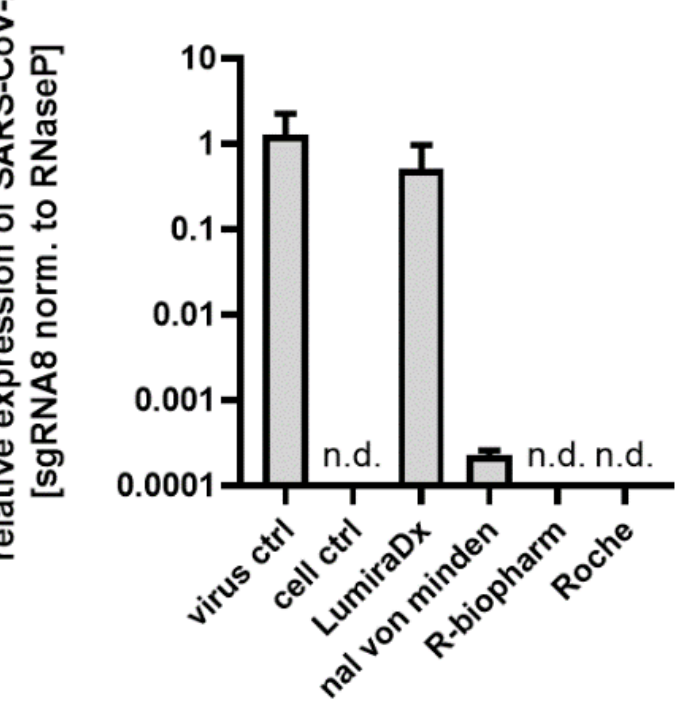
Figure 3. Detection and relative quantification of SARS-CoV-2 subgenomic mRNA isoforms in infected Caco2 cells. SARS-CoV-2 sgRNA8 mRNA levels were normalized to human RNaseP.